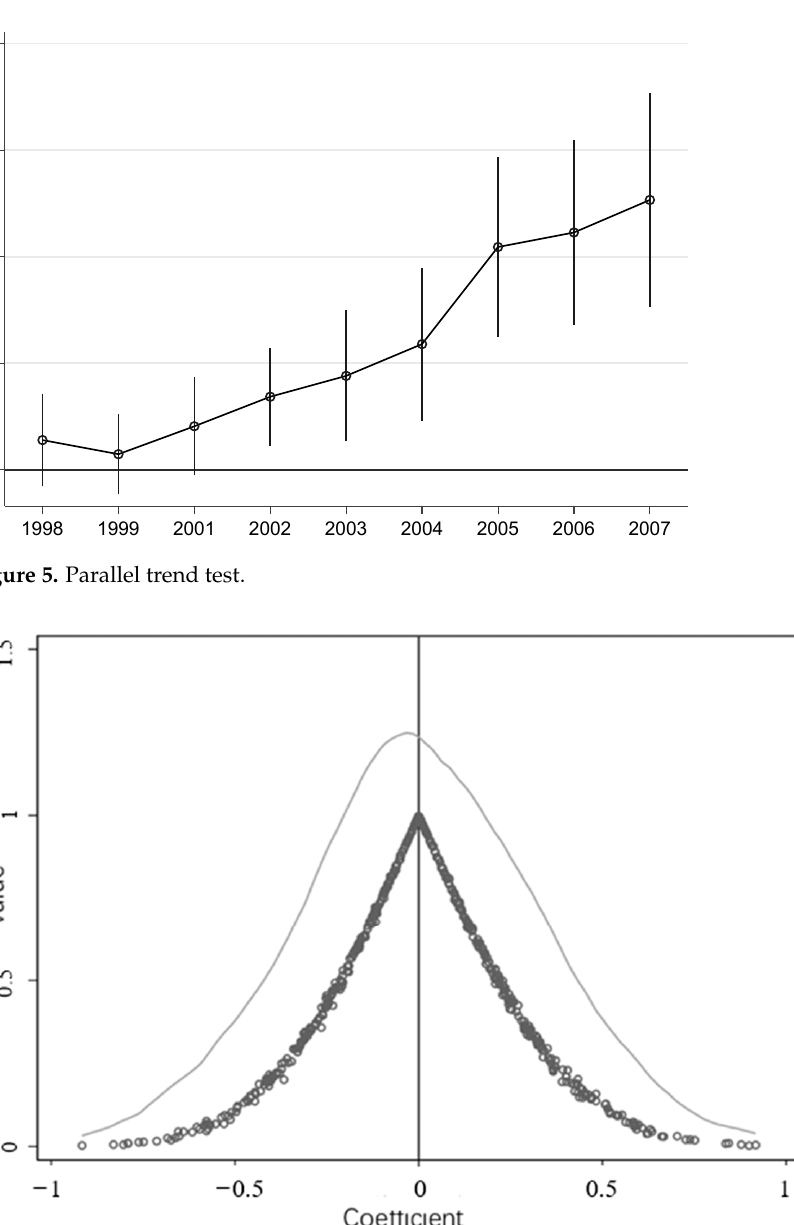
Figure 6. Coefficients and p -values of placebo tests for randomized treatment groups. Note: The circles represent the scatterplot of p -values and estimated coefficients; the lines represent the kernel density estimation of the estimated coefficients.